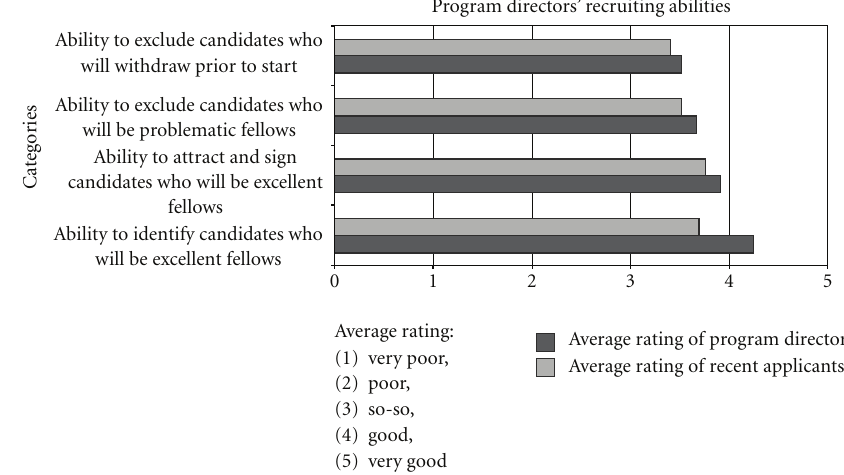
Figure 4: Bar chart comparing program directors’ self-assessment of their recruiting abilities with recent fellows’ assessments of the program directors’